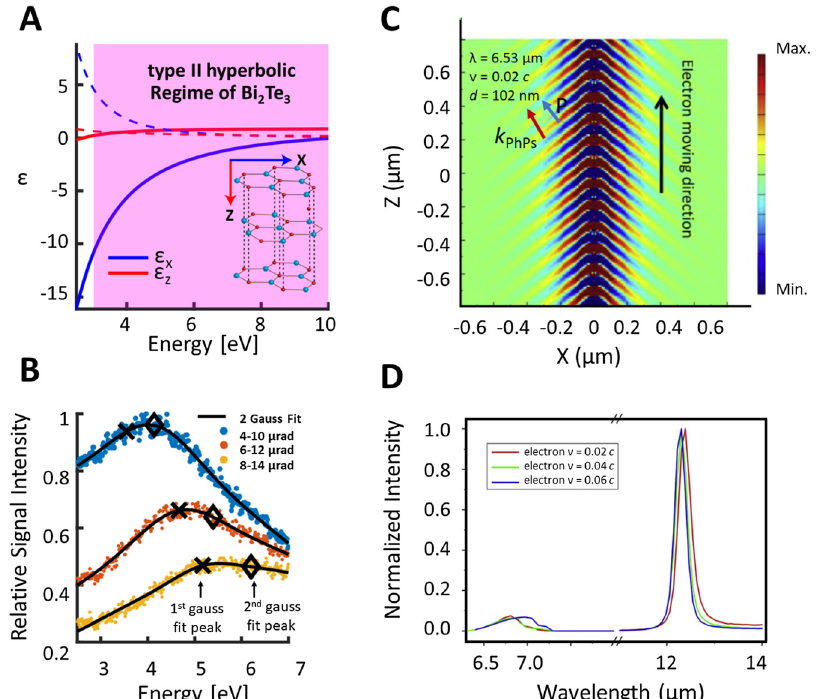
contributes to the EEL spectra, and a detailed analytic treatment of the EEL probability has been performed by